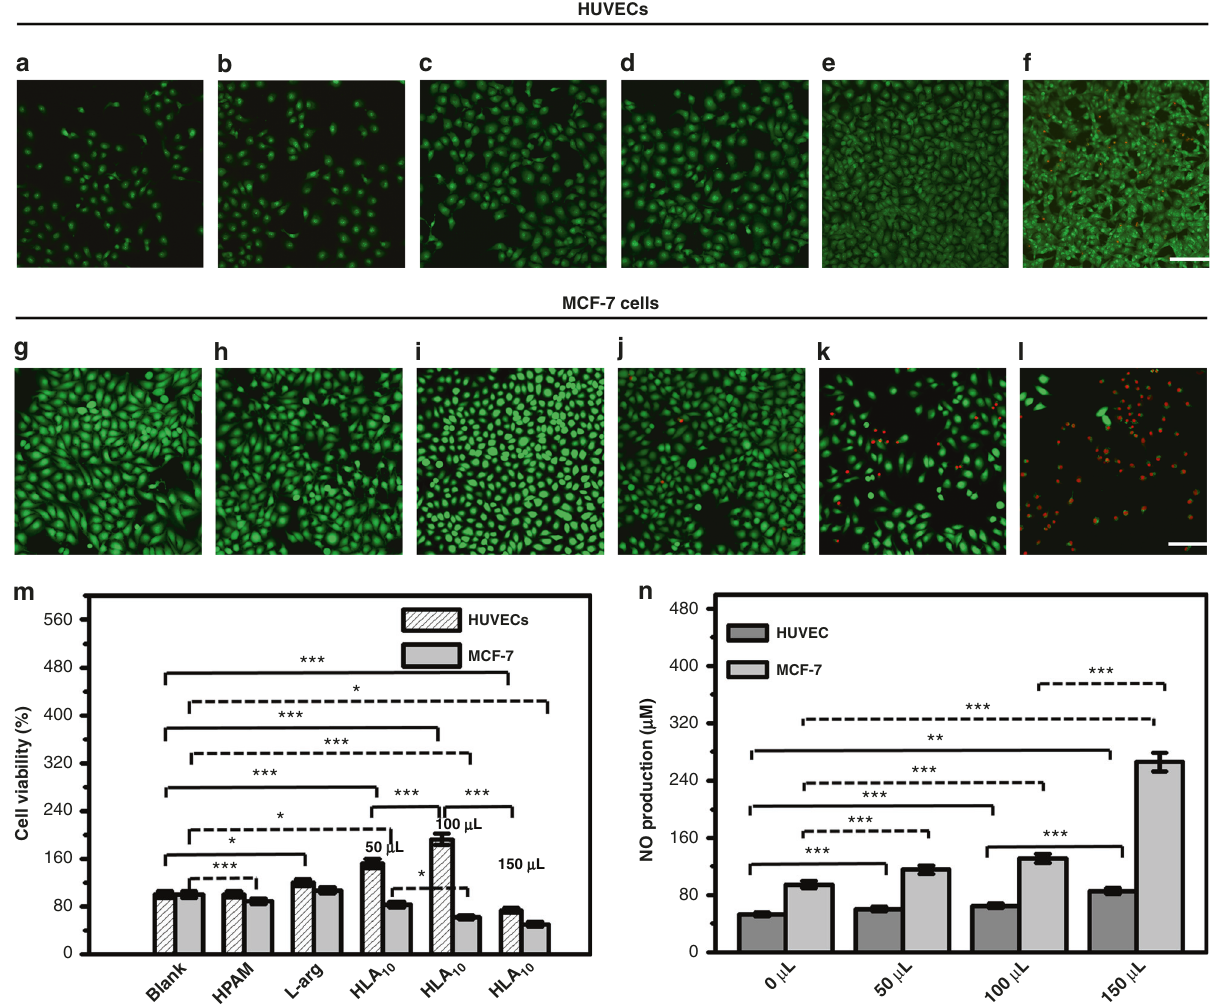
Fig. 6 Cell viabilities tests. Live/Dead cell images of a , g control cell, b , h cell + HPAM, c , i cell + L -arginine, d , j cell + HLA 10 nanomotor 50 μ L, e , k cell + HLA 10 nanomotor 100 μ L, f , l cell + HLA 10 nanomotor 150 μ L (Scale bar: 100 μ m); m MTT results the samples for different cells; n NO production amount during the co-culture of different amounts of HLA 10 nanomotor with HUVECs and MCF-7 cells for 4 h. Asterisk (*) denotes statistical signi fi cance between bars (* p < 0.05, ** p < 0.01, *** p < 0.001) using one-way ANOVA analysis. Experimental data are mean + / − s.d. of samples in a representative